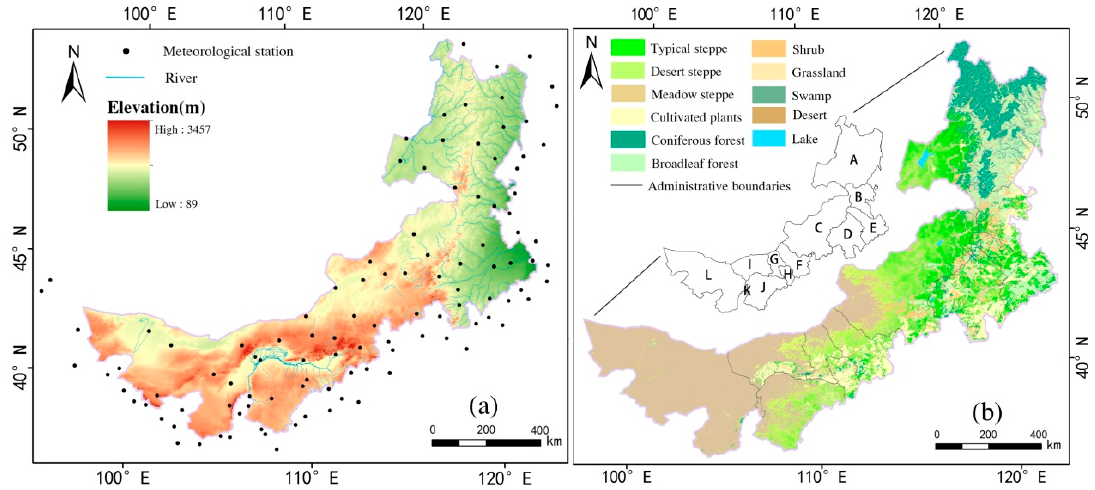
Figure 1. The Digital Elevation Model （ DEM ） and meteorological station distribution ( a ) and the vegetation types ( b ) in IMAR. (A—Hulunbuir; B—Hinggan League; C—Xilingol League; D—Chifeng; E—Tongliao; F—Ulanqab League; G—Baotou; H—Hohhot; I—Bayannur League; J—Erdos; K—